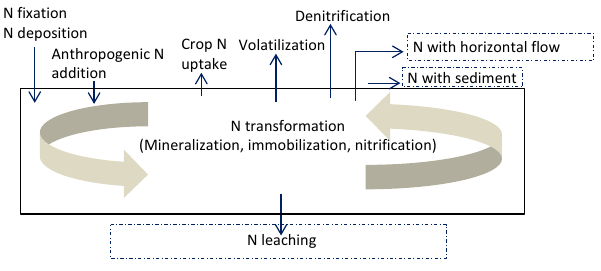
Figure 1. Nitrogen fluxes into and from the root zone, and N trans-